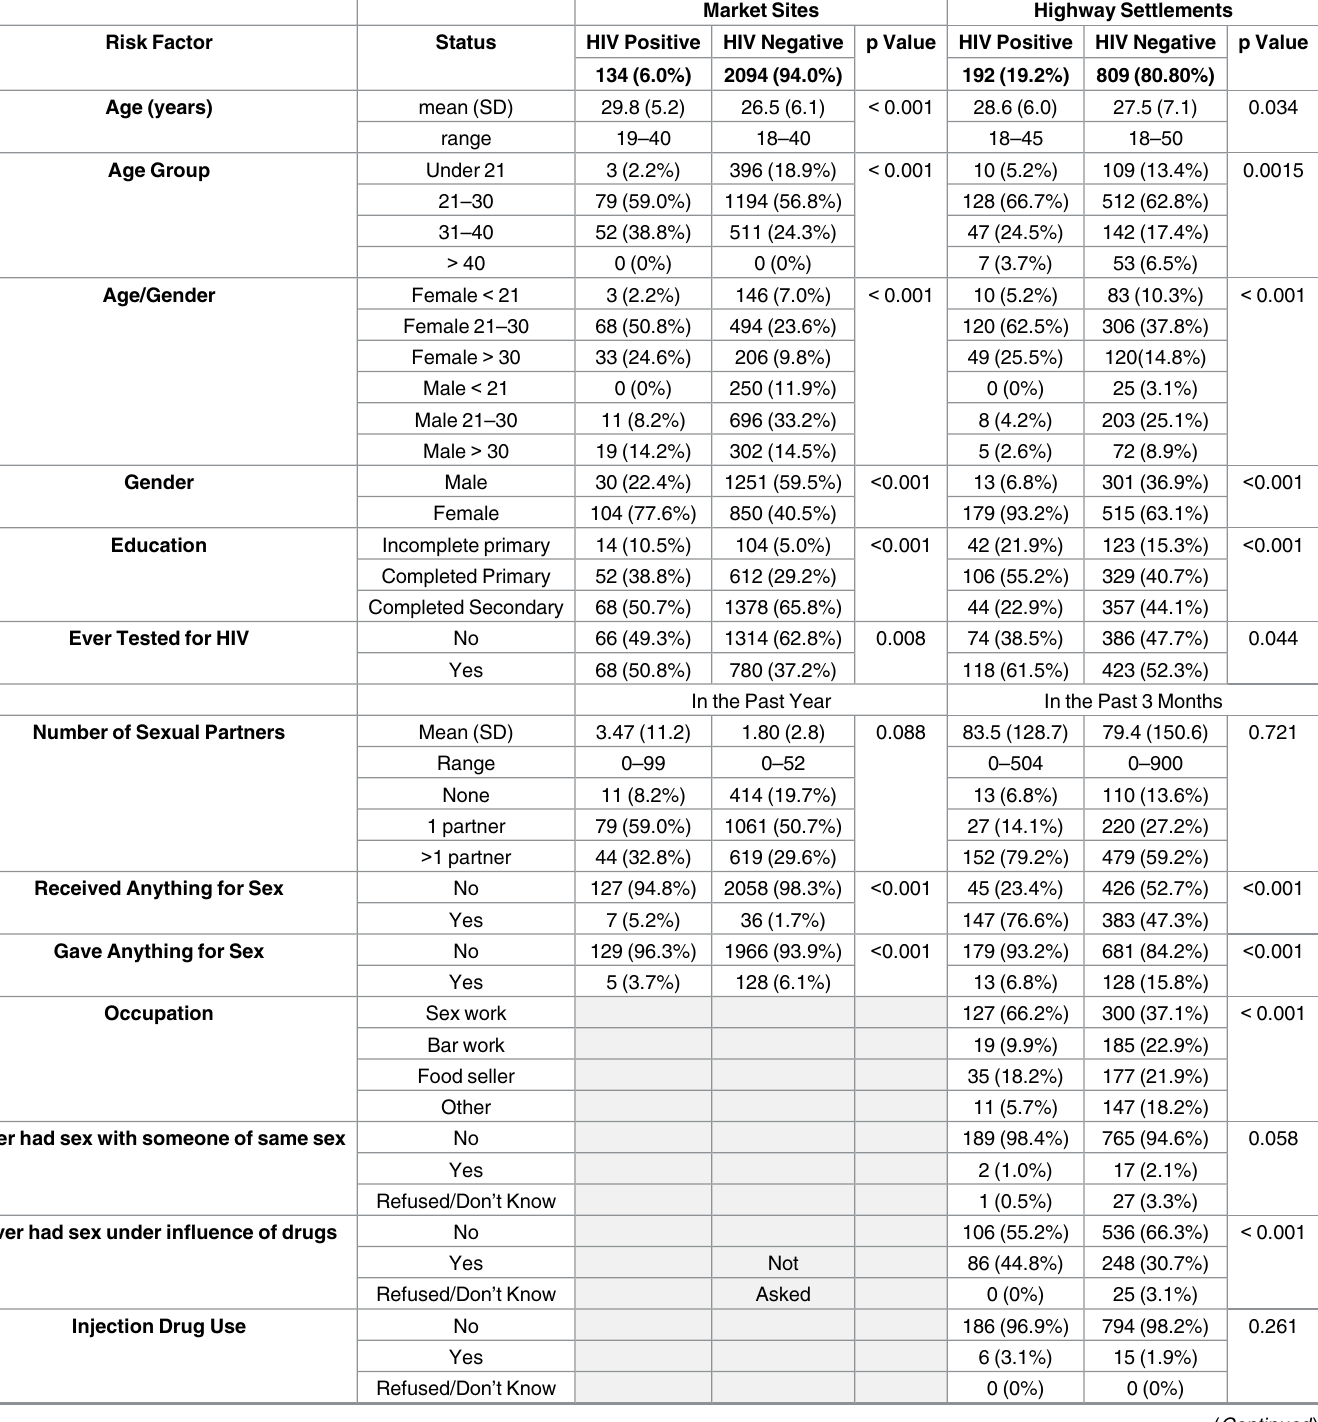
Table 2. Univariate Analysis of HIV Risk Factors at the various study sites. The HighwaySettlement sites were added after study initiation,and included more risk factors and focused sexual activity questionsonly on the past 3